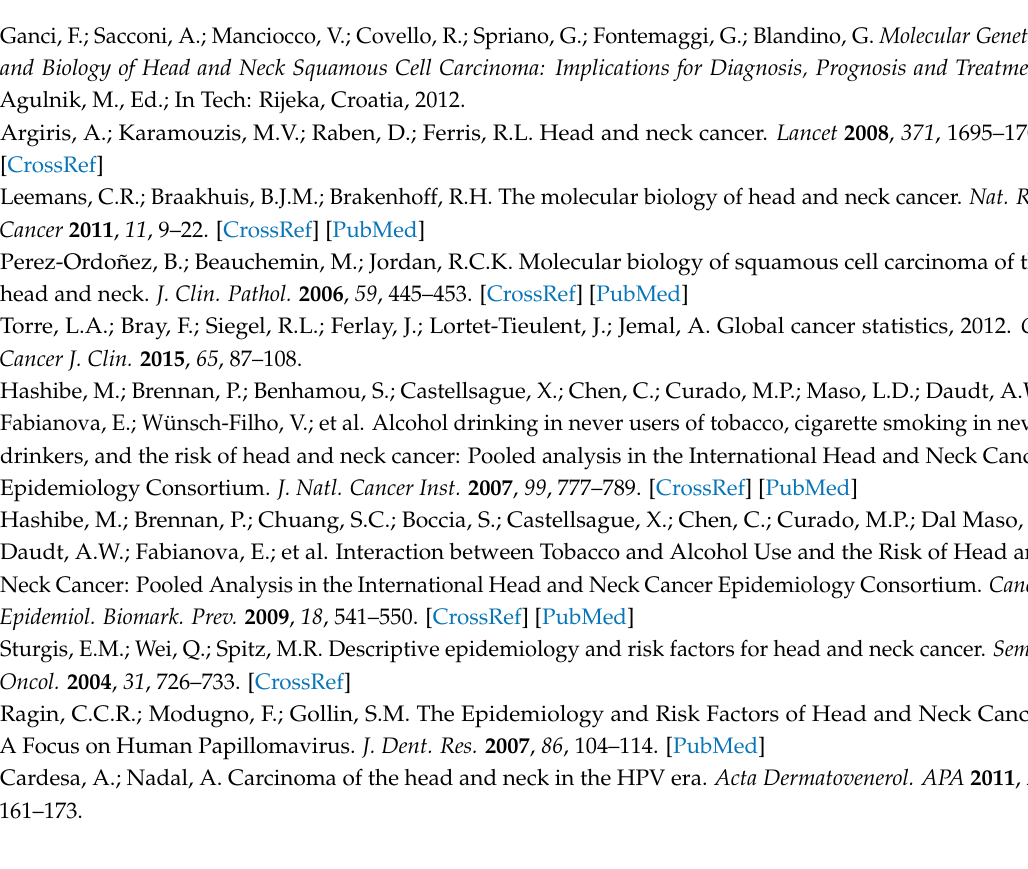
Table S1: Primer sequences and genotyping assays in those SNPs defined in Table 5 without specific TaqMan ® probes, Table S2: Distribution between studied SNPs in different genes in laryngeal tumours (Ca) and controls (Co)*, Table S3: Distribution between studied SNPs in different genes in tumours from oral cavity (Ca) and controls (Co), Table S4: Distribution between studied SNPs in different genes in pharyngeal tumours (Ca) and controls